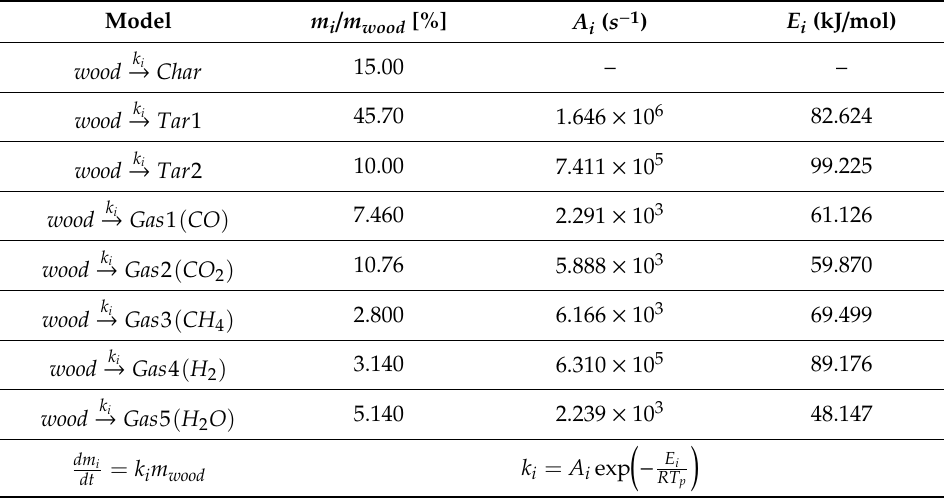
Table 1. Gasification and / or devolatilization model one